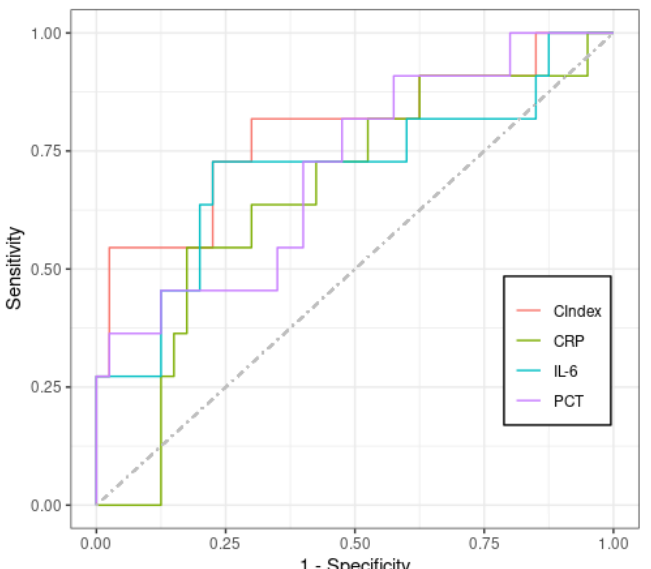
Table 2. Values for ROC curve performance measurements for a chosen cut-off value, maximising both sensitivity and specificity.